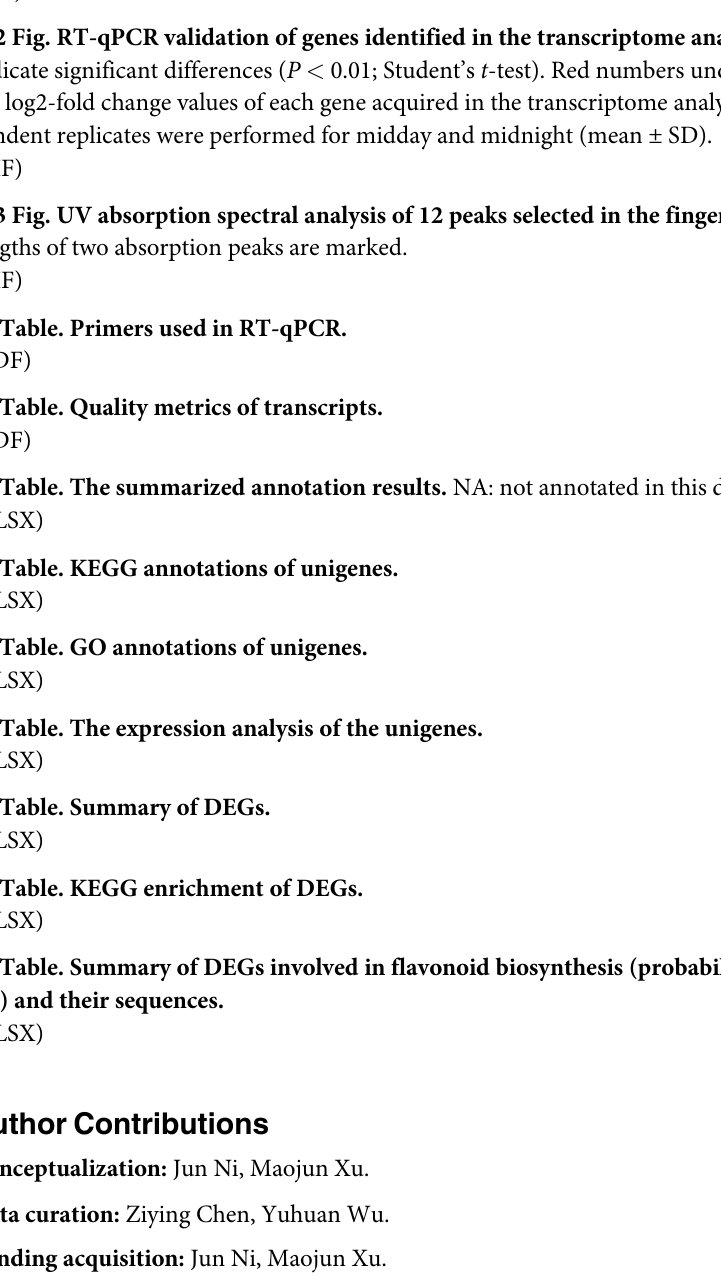
S11 Fig. Flavonoid biosynthesis pathways in Ginkgo. Steps identified in our transcriptome analysis are marked by red boxes. S12 Fig. RT-qPCR validation of genes identified in the transcriptome analysis. Asterisks indicate significant differences ( P < 0.01; Student’s t -test). Red numbers under the bar graphs are log2-fold change values of each gene acquired in the transcriptome analysis. Three inde- pendent replicates were performed for midday and midnight (mean ± SD). S13 Fig. UV absorption spectral analysis of 12 peaks selected in the fingerprint. The wave- lengths of two absorption peaks are marked. S1 Table. Primers used in RT-qPCR. S2 Table. Quality metrics of transcripts. S3 Table. The summarized annotation results. NA: not annotated in this database. S4 Table. KEGG annotations of unigenes. S5 Table. GO annotations of unigenes. S6 Table. The expression analysis of the unigenes. S7 Table. Summary of DEGs. S8 Table. KEGG enrichment of DEGs. S9 Table. Summary of DEGs involved in flavonoid biosynthesis (probability greater than 0.5) and their